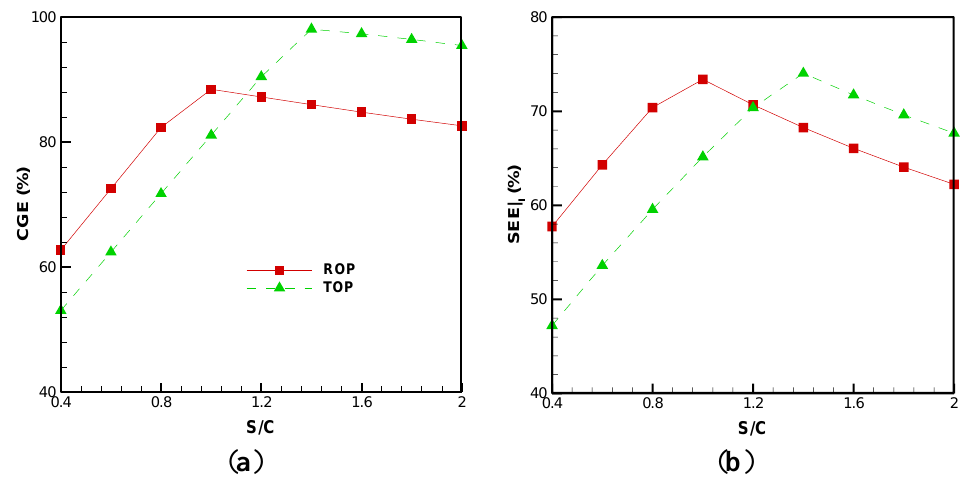
Figure 5. Effects of the S/C ratio on distributions of ( a ) cold gas efficiency; ( b ) system energetic efficiency.